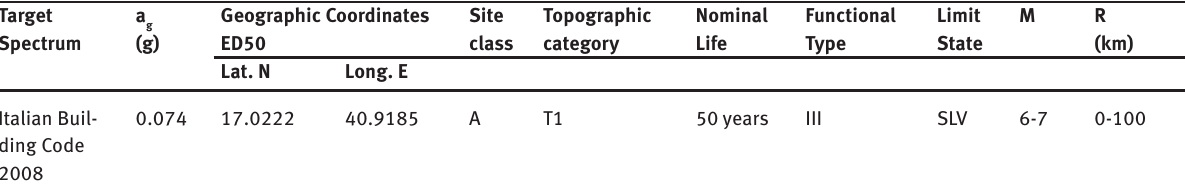
Table 3: Relevant input data for the accelerograms search with the REXEL 3.5 software. Target Spectrum